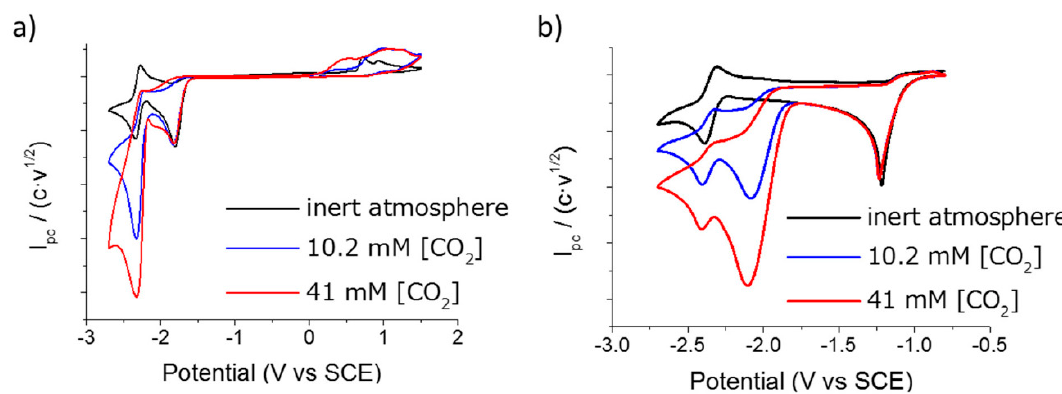
Figure 4. Cyclic voltammograms of 5 mL solution in DMF/0.10 M TBABF 4 containing 10.2 mM 4- iodobenzonitrile under a nitrogen atmosphere and CO 2 atmosphere using ( a ) GC and ( b ) Ag. Scan rate 0.5 V s − 1.